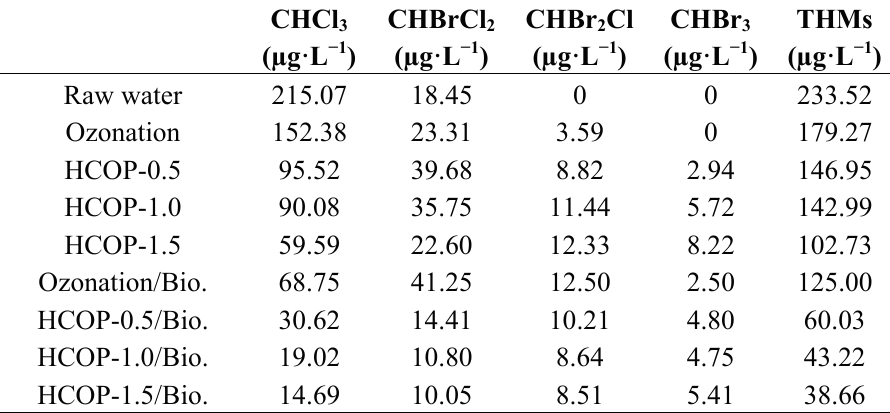
Table 4. The concentrations of individual THM species under different experimental conditions.